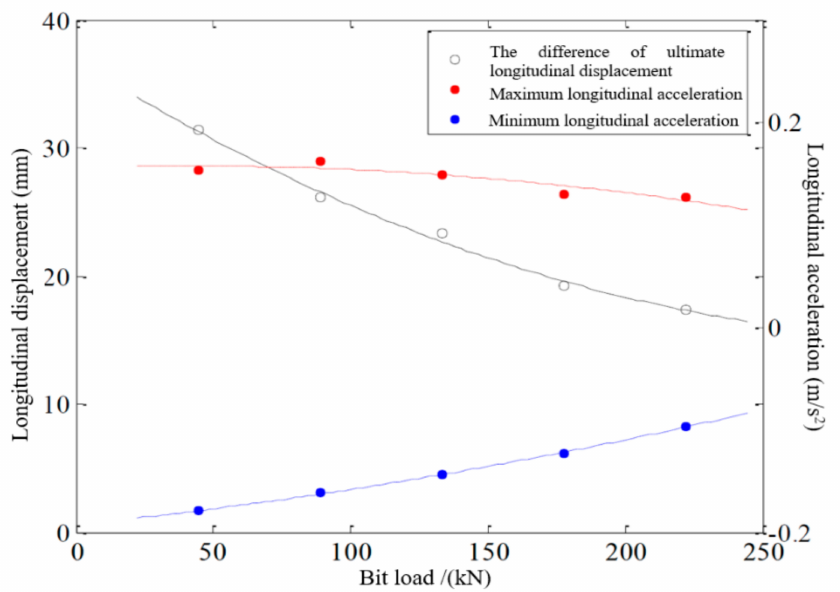
Figure 14. The variation of longitudinal motion amplitude and ultimate acceleration of drill string with bit